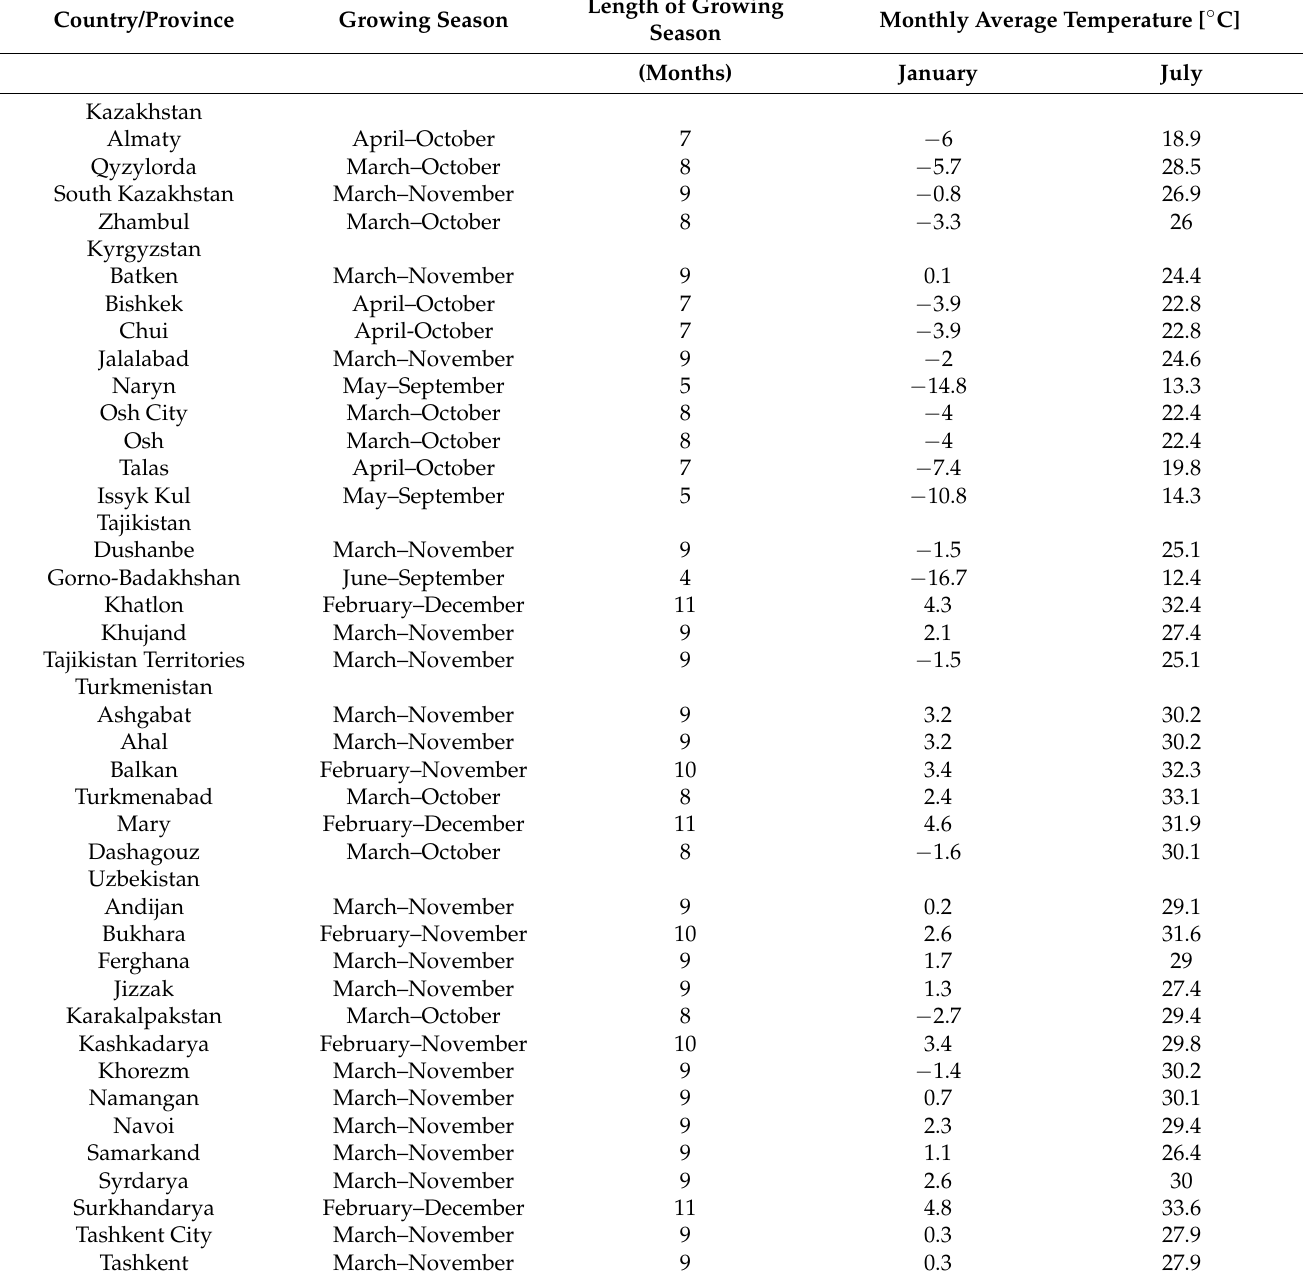
Table 1. Growing season, expressed as number of months with an average air temperature of ≥ 5 ◦ C, and monthly average air temperature of January and